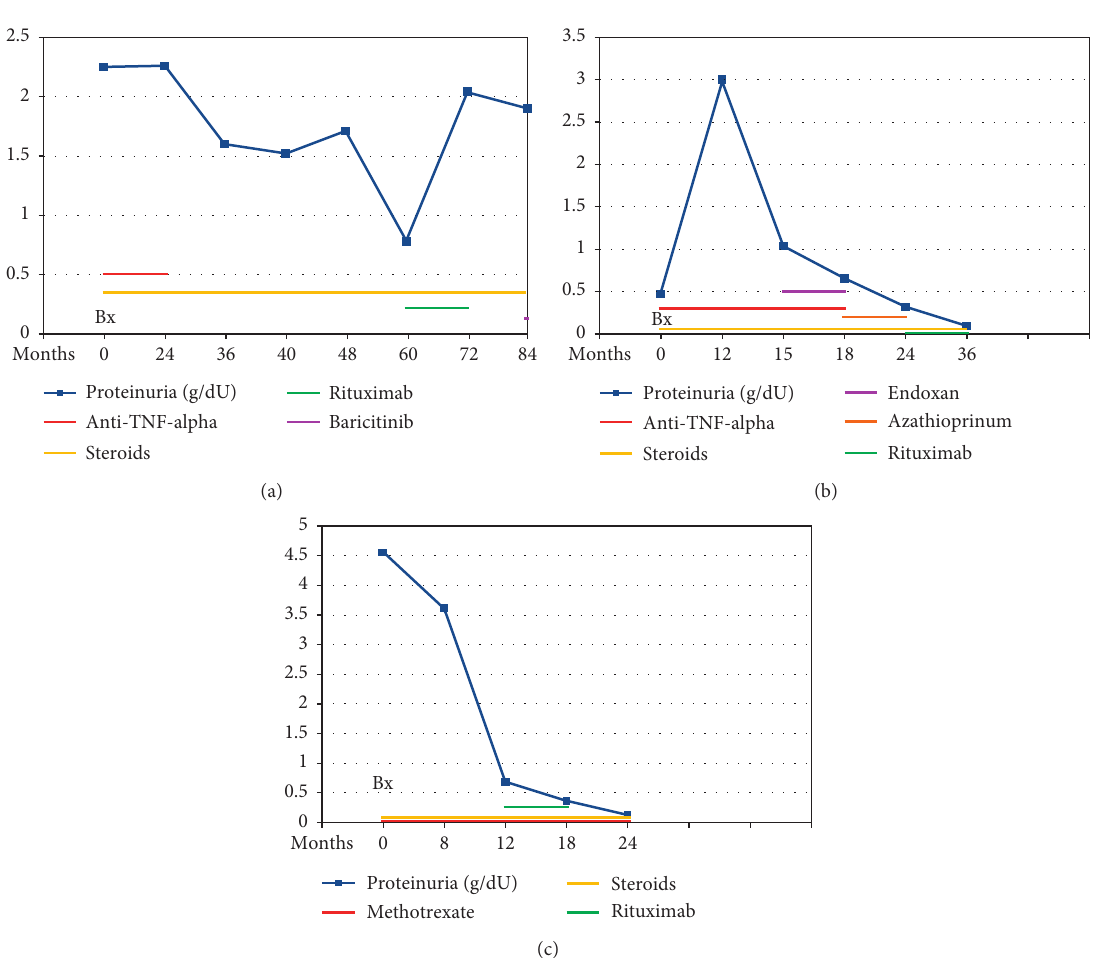
Figure 2: Proteinuria and therapy after kidney biopsy. Case 1 (a); Case 2 (b); Case 3